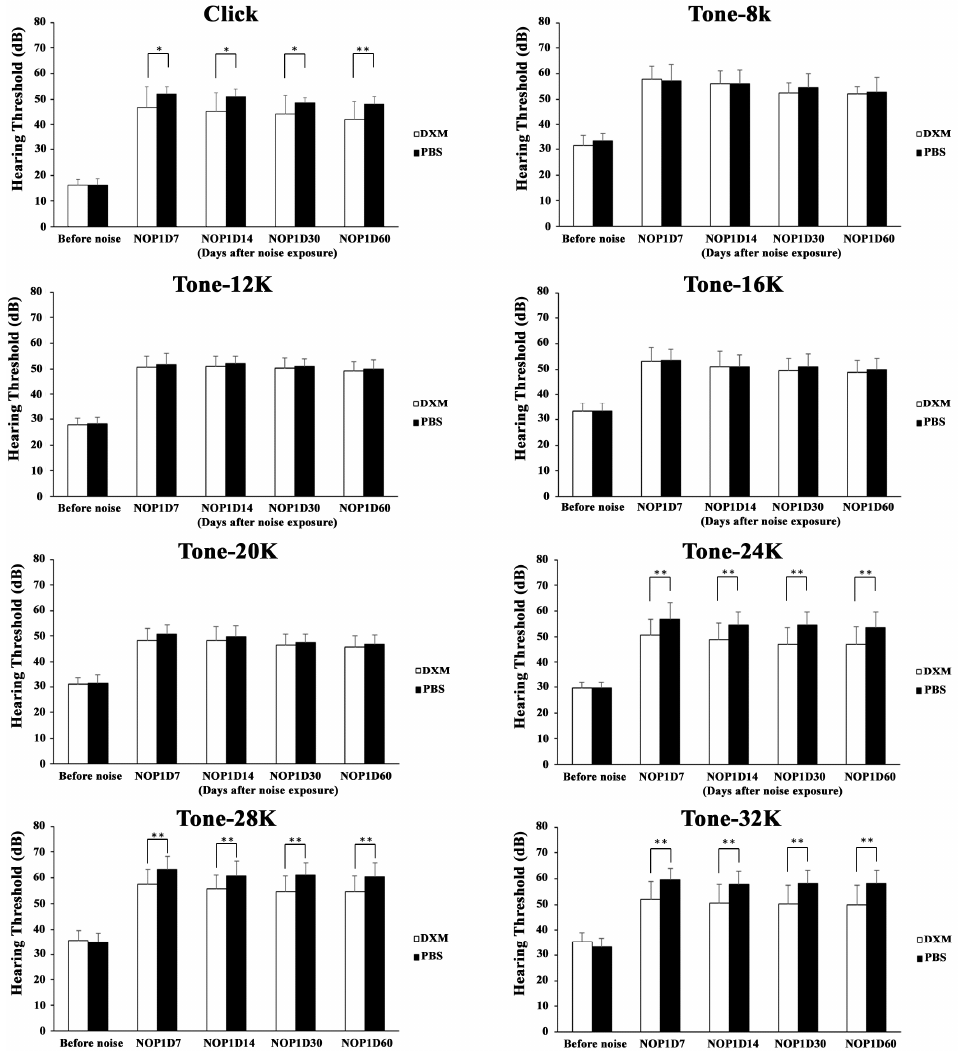
Figure 2. Click and tone burst ABR for hearing evaluation at various time points. The hearing threshold obtained through click ABR (42.6 ± 7.0 dB, n = 22) in the DXM group was significantly ( p = 0.002) better than that (48.6 ± 2.9 dB, n = 18) in the control group after noise exposure. In terms of tone burst ABR, the hearing threshold between 24 and 32 kHz in the DXM group was significantly better than that in the control group after noise exposure. * p < 0.05, ** p < 0.01